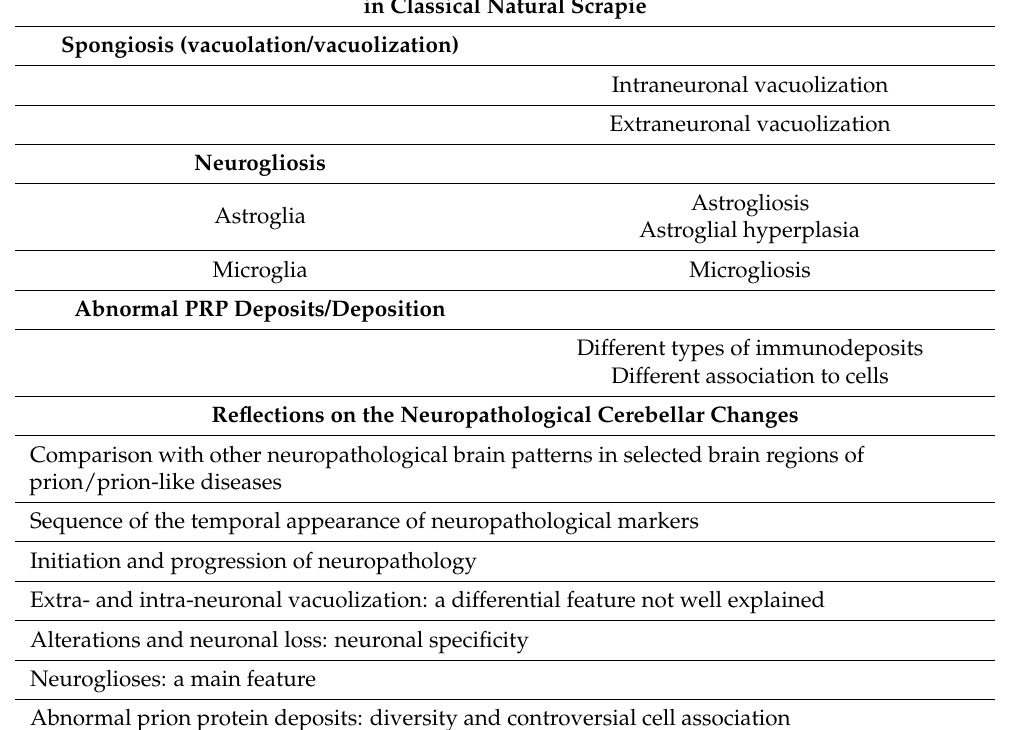
Table 1. Cont. Cerebellar Neuropathological Abnormalities